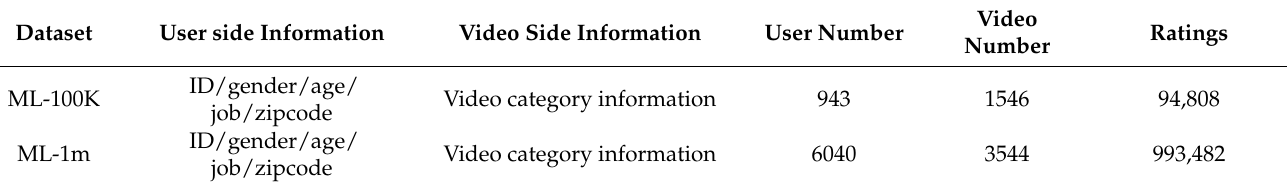
Table 2. Statistics of the two preprocessed